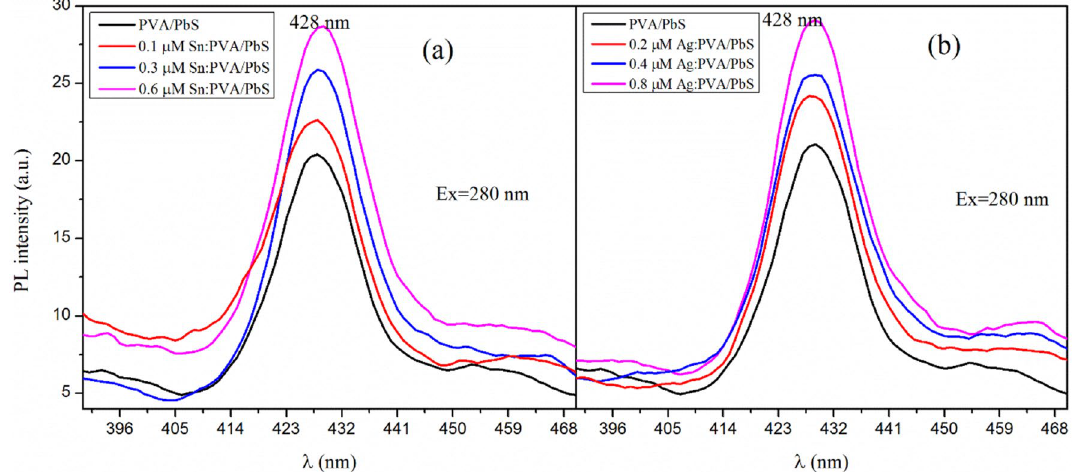
Figure 7. PL intensity of ( a ) undoped and Sn doped PbS/PVA ( b ) un-doped and Ag-doped